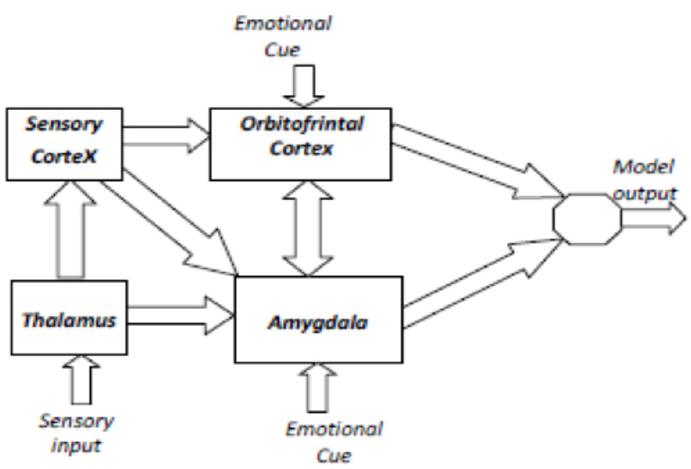
Figure 6. A graphical scheme of the single-layer emotional controller, adopted from [22].